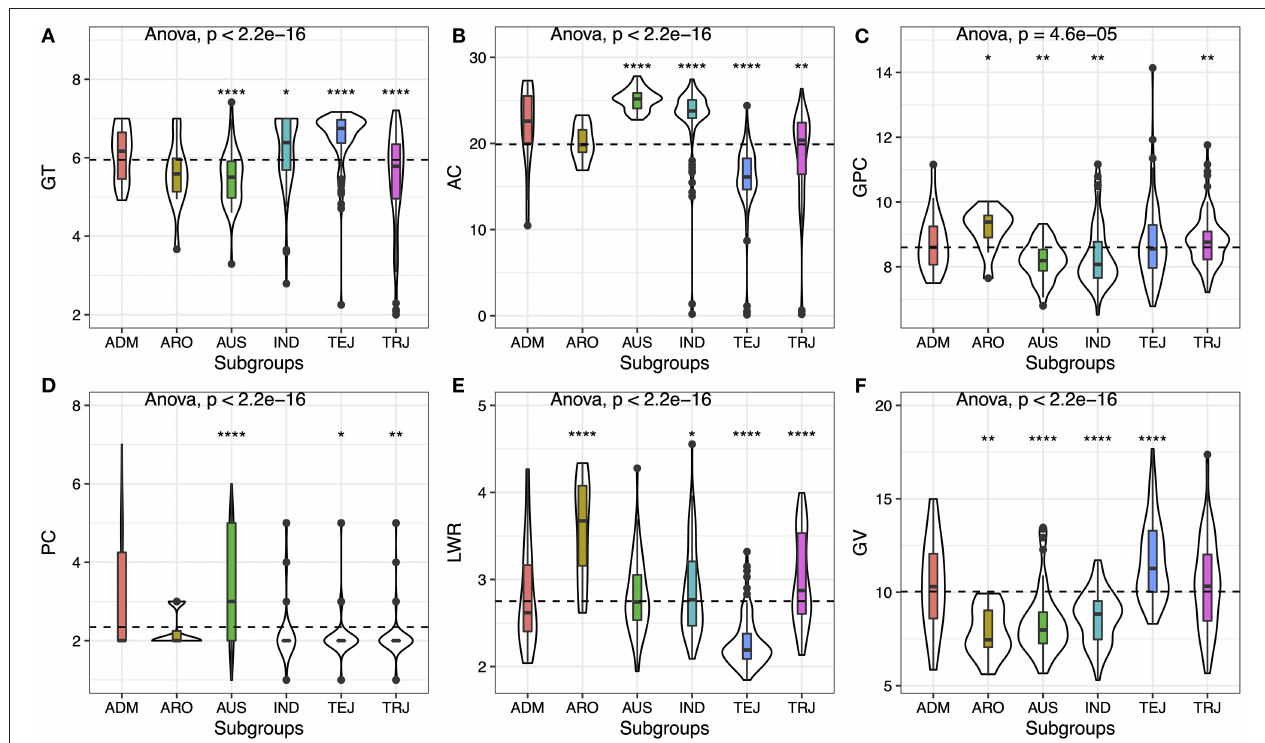
FIGURE 1 | Phenotypic variation of six traits among the rice subgroups. (A) Gelatinization temperature (GT), (B) amylose content (AC), (C) grain protein content (GPC), (D) pericarp color (PC), (E) length/width ratio (LWR), and (F) grain volume (GV). Violin plots show the dispersion and the distribution of the traits in subgroups. Whiskers represent 1.5 times the interquartile of the data. The upper and lower edge of the box presents the interquartile range of the data. The thick black bar in the center represents the median of the data. The one-way ANOVA test is used to determine whether there are any statistically significant differences between the subgroups, and the p -value is shown on the left corner of each figure. The total population acts as a reference group, and each subgroup is compared with the reference group. Different symbols above each subgroup indicate significant differences: * p < 0.05,** p < 0.01,*** p < 0.001, and **** p < 0.0001. The dashed black line represents the mean value of the whole